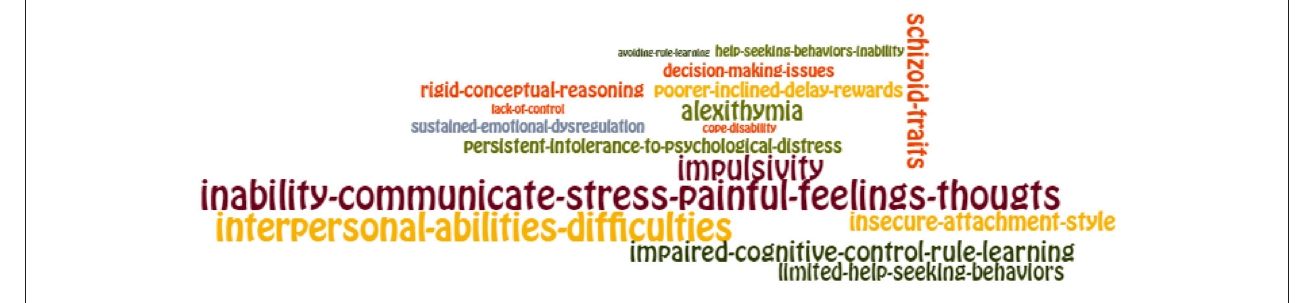
FIGURE 3 | Traits of suicidal mental